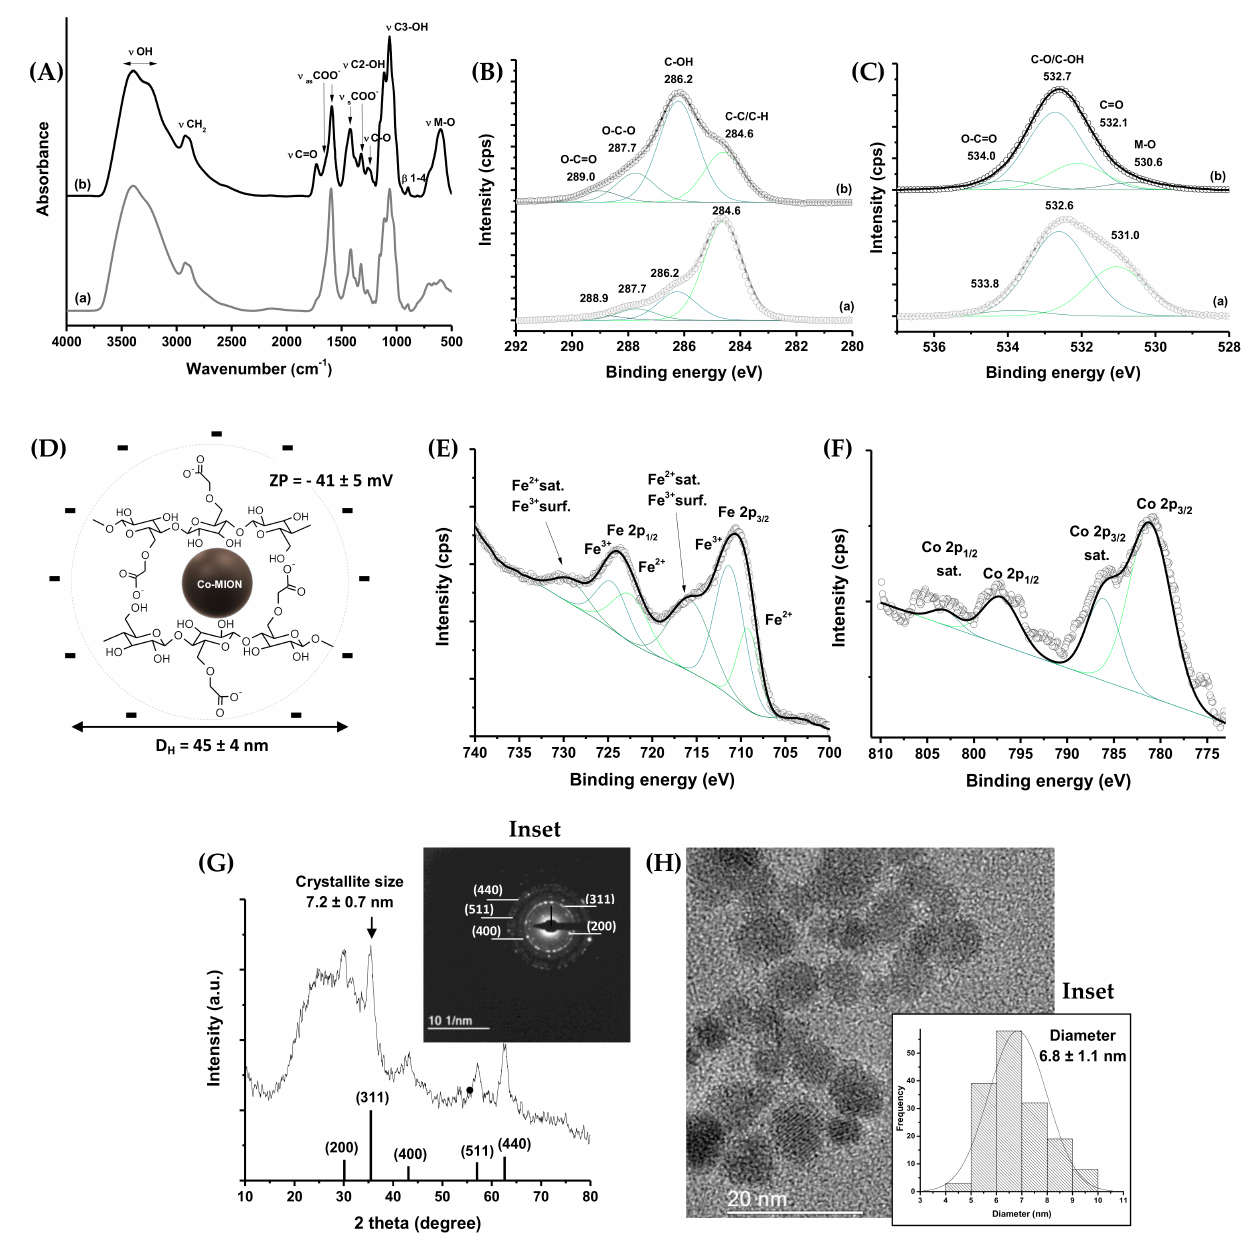
Figure 2. Characterization of Co-MION@CMC: ( A ) FTIR and HR-XPS spectra, and ( B ) C 1s and ( C ) O 1s regions, were obtained from ( a ) CMC polymer and ( b ) Co-MION@CMC nanostructure. ( D ) Schematic representation of the supramolecular structure of the nanosystem, with ZP and D H information. HR-XPS spectra of the ( E ) Fe 2p and ( F ) Co 2p regions. ( G ) XRD pattern with diffraction planes compared to magnetite’s ICCD file (inset: SAED diffraction lines). ( H ) TEM image (inset: histogram of size